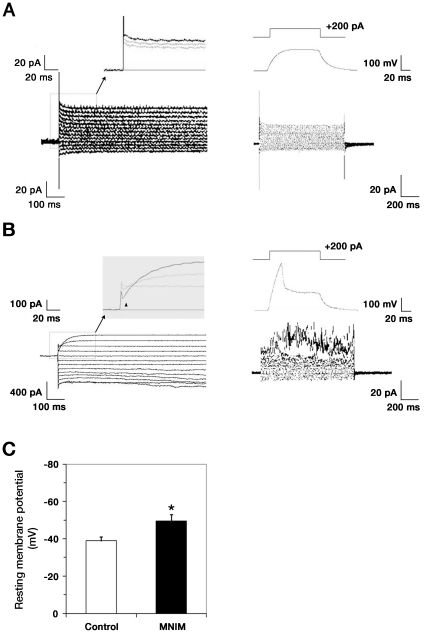
Excitable properties of MNIM-treated EOH cells.Representative perforated patch clamp recordings from uninduced EOH cells (A) or MNIM-EOH cells (B). The cells were held at −60 mV and currents elicited by stepping from −90 to +30 mV in 10 mV steps. MNIM-EOH cells express robust outward K+ currents but very small inward Na+ currents (filled upright triangle). Current injection (200 pA, 100 ms) induced action potential in MNIM-EOH cells, not in uninduced EOH cells. (C) Resting membrane potential in uninduced EOH cells and MNIM-EOH cells. The bars represent mean ± SEM. * P<0.05. The significance was determined by Student’s t test.